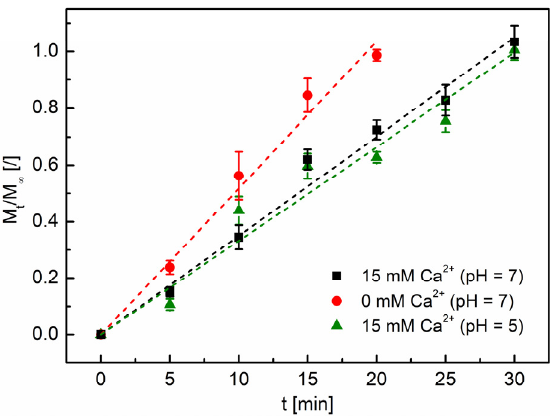
Figure 3. Normalized bacteriophage released at 37 °C as a function of time. The colors represent the concentration of ionic crosslinking agent (Ca 2+ ) and the pH of the release medium.